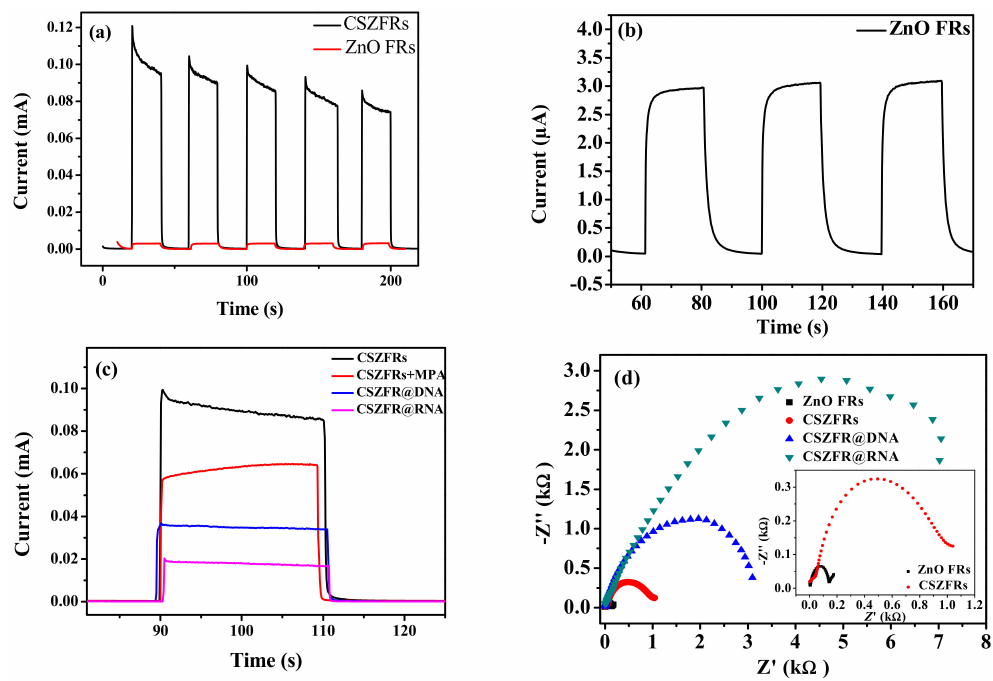
Figure 4. ( a ) Photocurrent of CSZFRs and ZnO FRs; ( b ) Photocurrent of pure ZnO FRs; ( c ) The photocurrents of different samples; ( d ) Electrochemical impedance spectroscopy for different samples. The inset of ( d ) is EIS of ZnO FRs and CSZFRs.